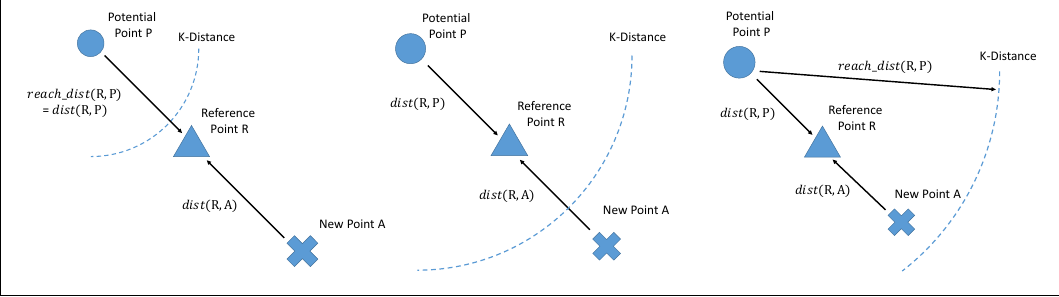
Figure 3. Three scenarios of a potential neighbor, a reference point, and a new